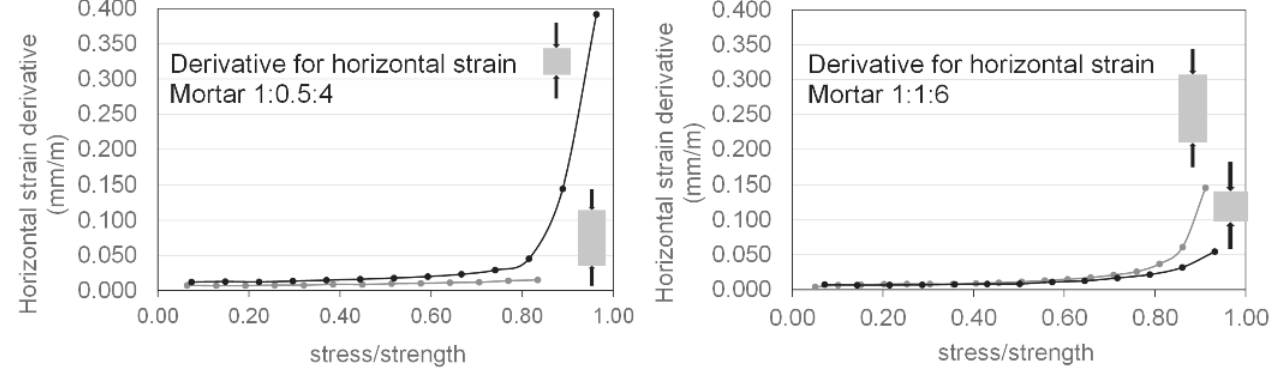
Derivative for horizontal strain for different stress/strength